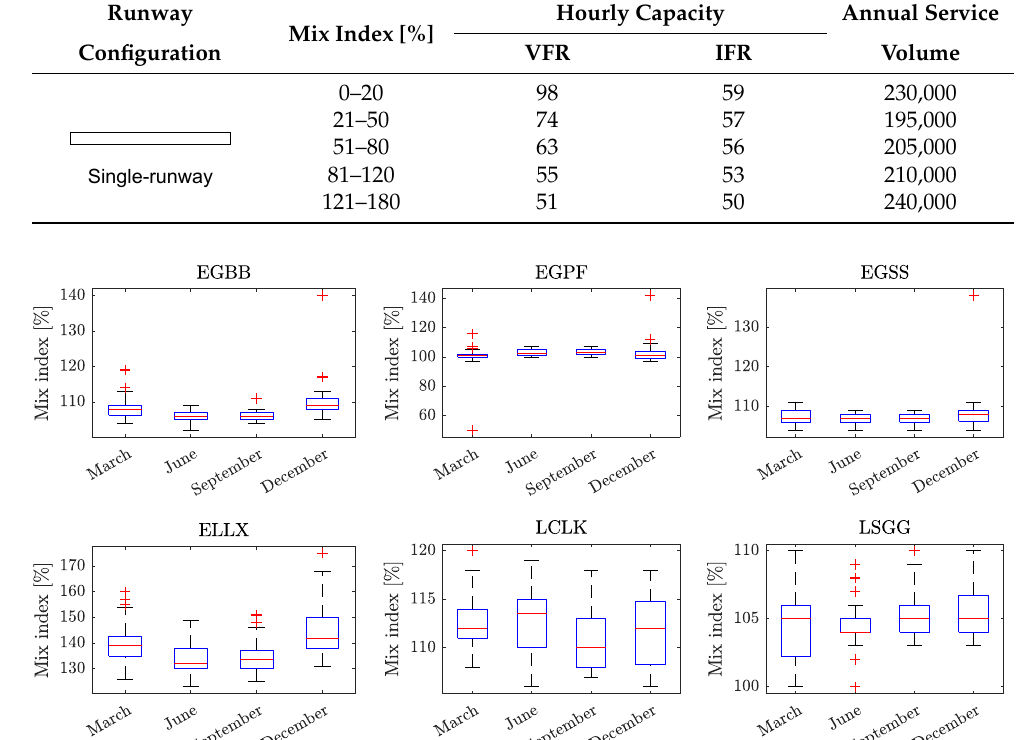
Table 3. Estimates of hourly and annual capacities for an single runway configuration and different aircraft mix indexes. Source: own representation based on [46].